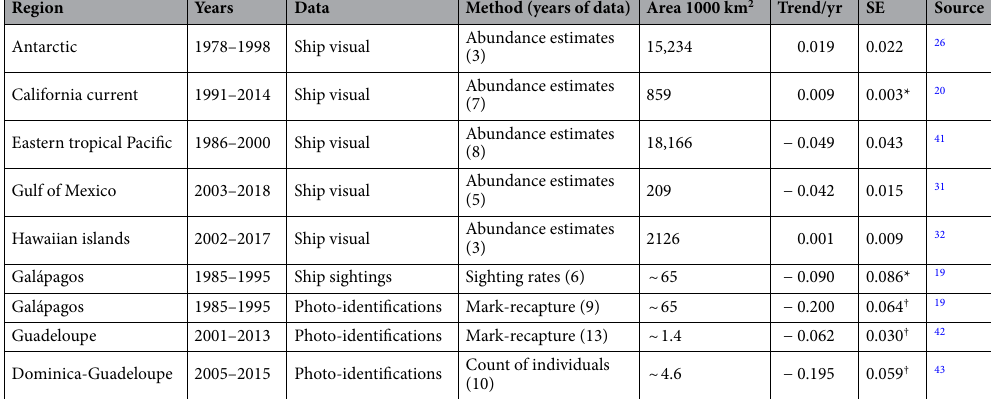
Table 3. Studies used in post-whaling trend analysis. *Calculated using weighted regression from presented data. † Calculated from presented confidence interval.